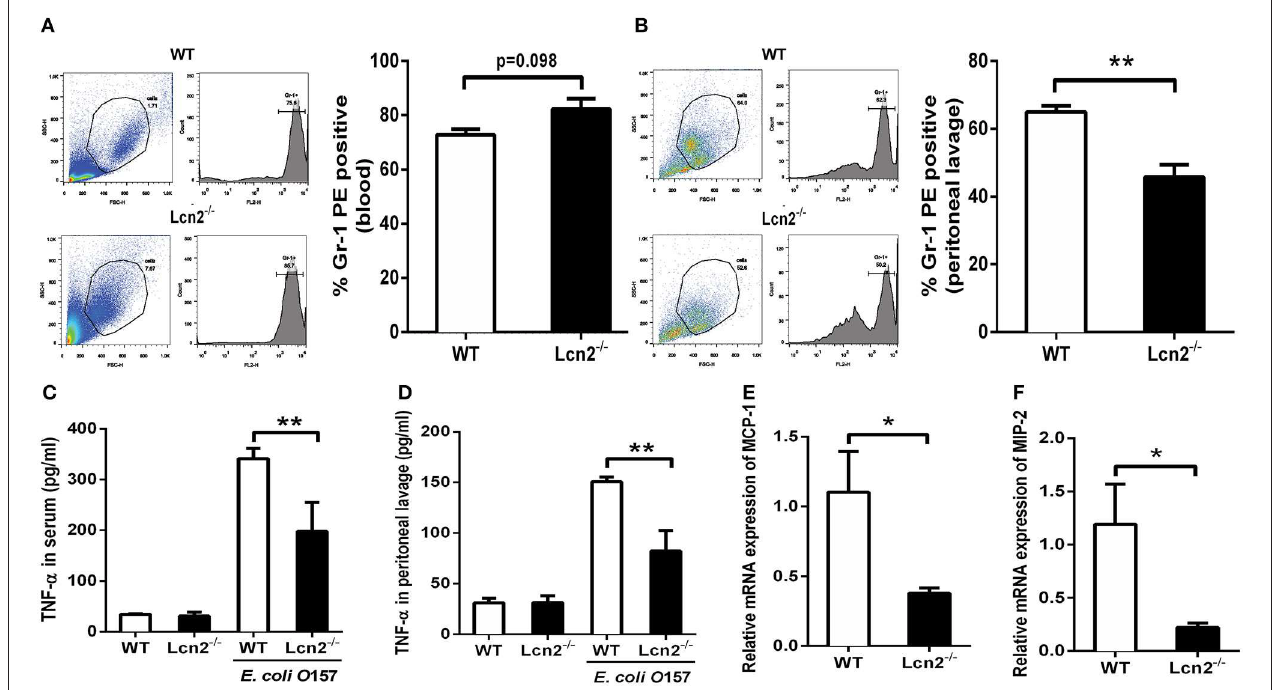
FIGURE 4 | Reduced migration of lipocalin 2-deficient ( Lcn2 − / − ) neutrophils. (A,B) Flow cytometry analysis of peripheral blood and peritoneal exudates of heat-killed E. coli O157:H7-challenged mice following staining with a Gr-1 PE Ab. (C,D) ELISA analysis of TNF- α in the serum and peritoneal exudates of heat-killed E. coli O157:H7-challenged mice. (E,F) Quantitative determination of chemokines MCP-1 and MIP-2 mRNA expression in the liver of heat-killed E. coli O157:H7-challenged mice. Values are average means of triplicate experiments with two mice per genotype per experiment. Error bars depict SEM. Results are expressed as means ± SEM. P < 0.05 was considered statistically significant. * P < 0.05 and ** P < 0.01.